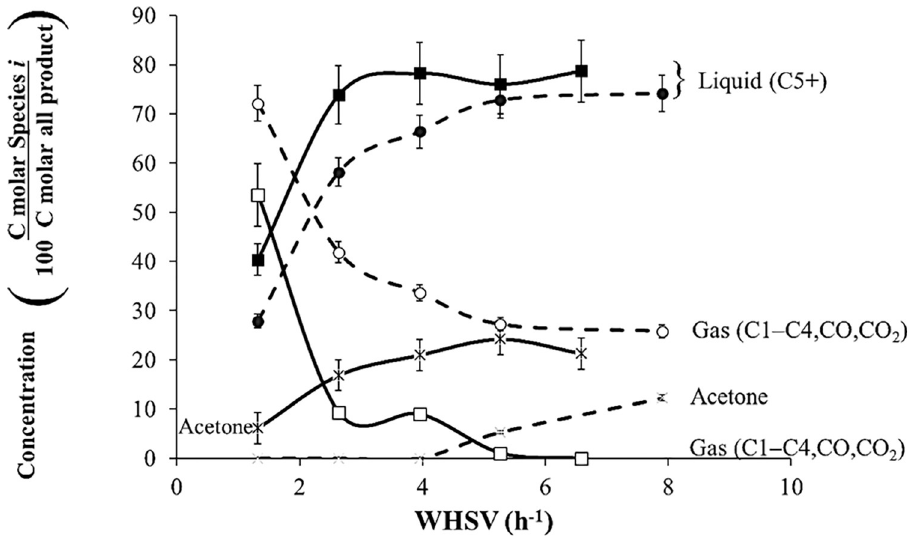
Fig 8. Product distribution of gases and liquids for the acetone reaction over HZSM-5 (80), T = 350 (solid line) and 415˚C (dashed line), and P = 101 kPa (abs).